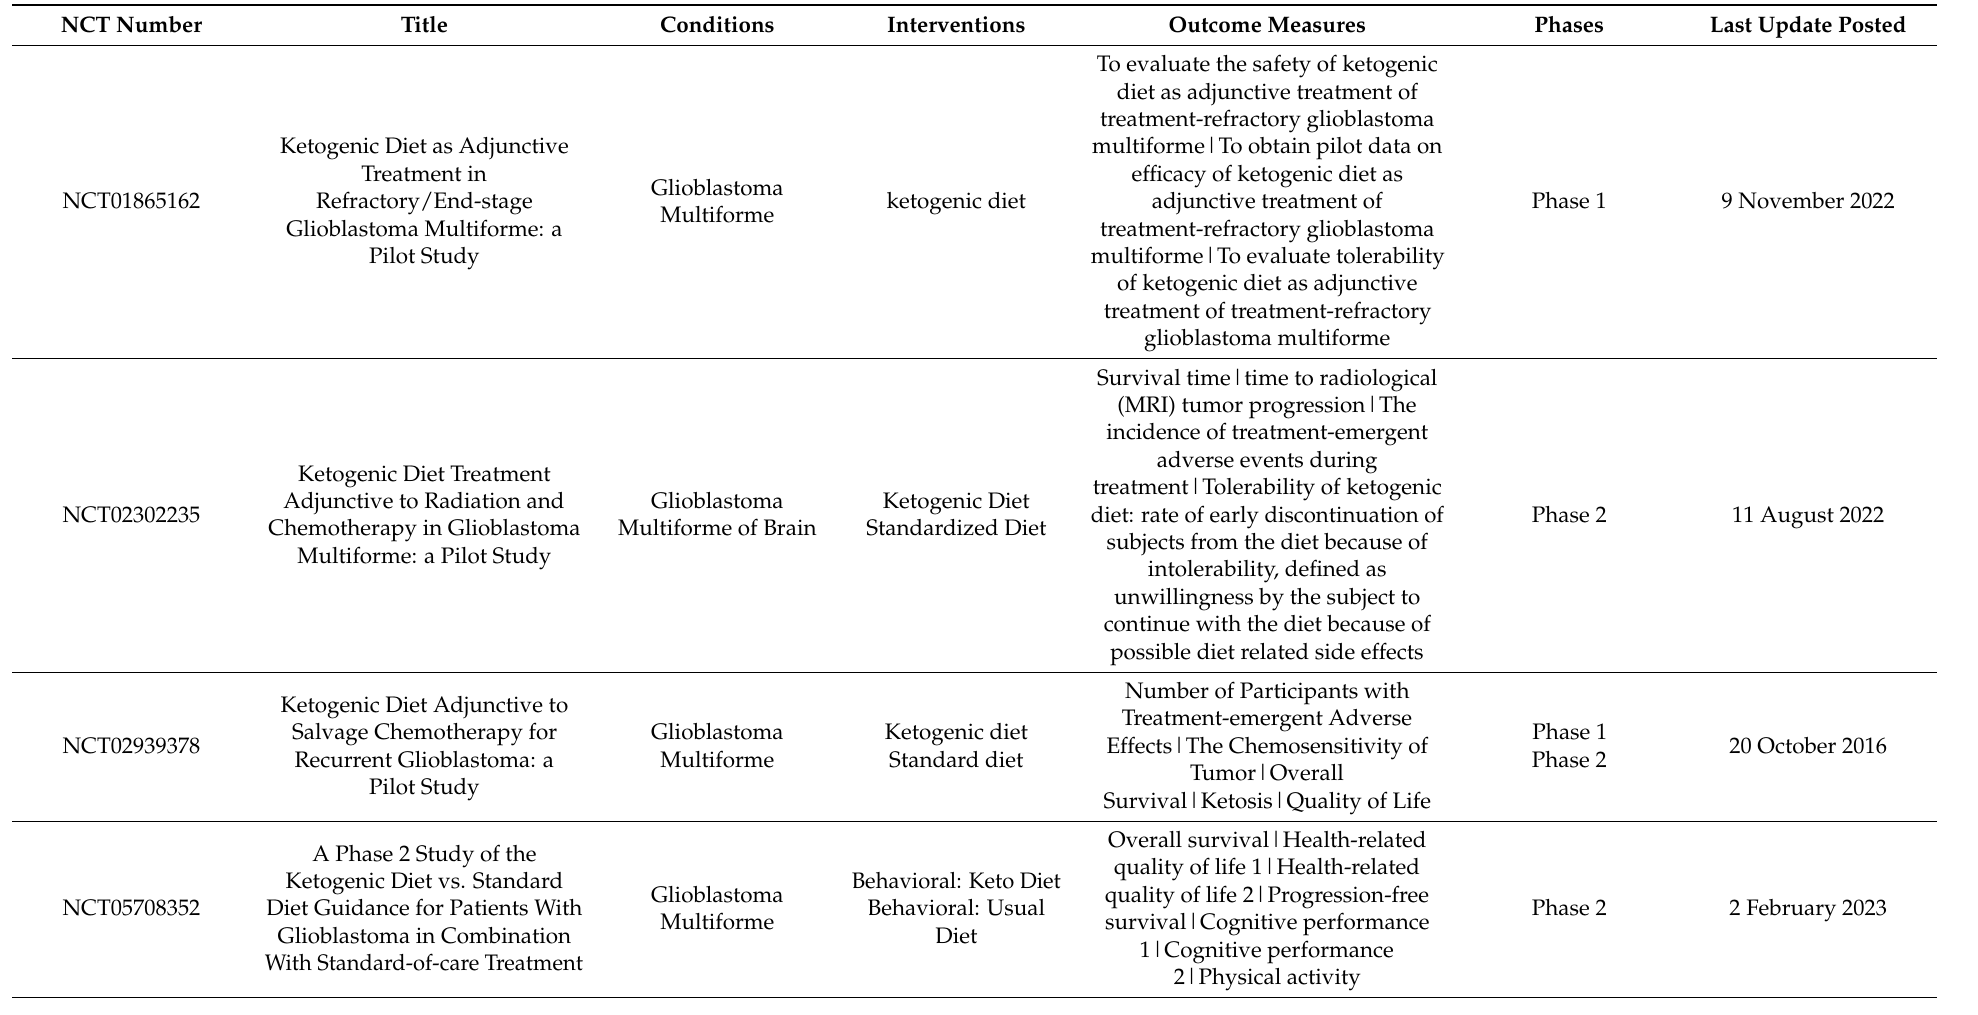
Table 1. The examples of ongoing clinical trials of the ketogenic diet for the treatment of glioblastoma multiforme